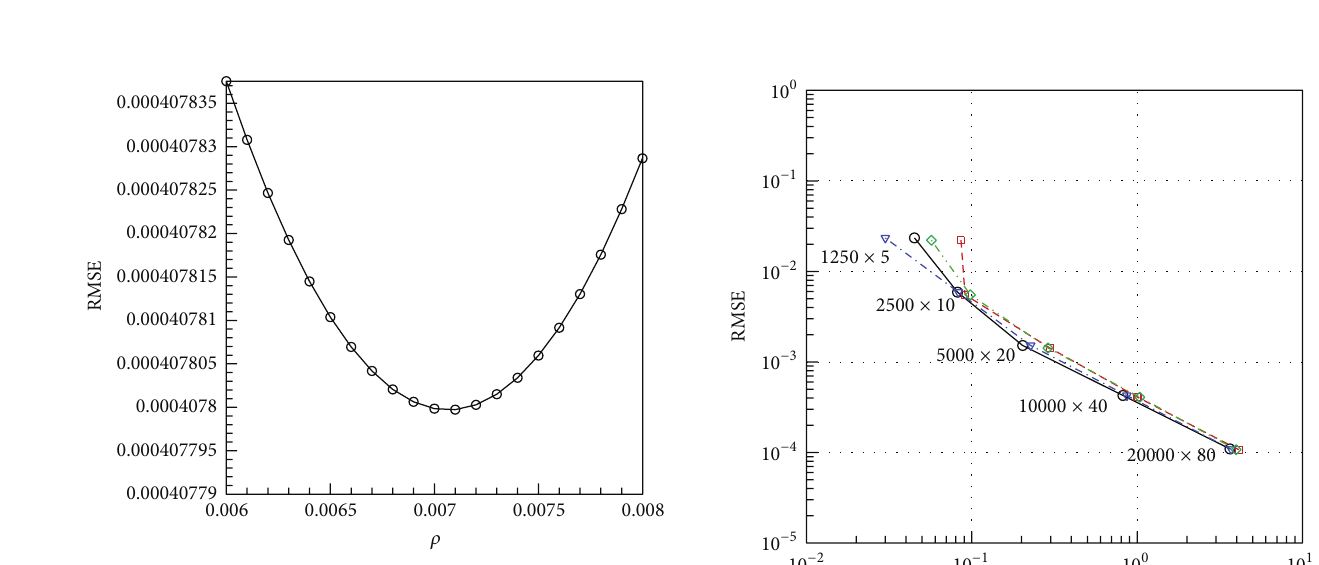
Figure 2: RMSE of the safety parameter 𝜌 in the solution.